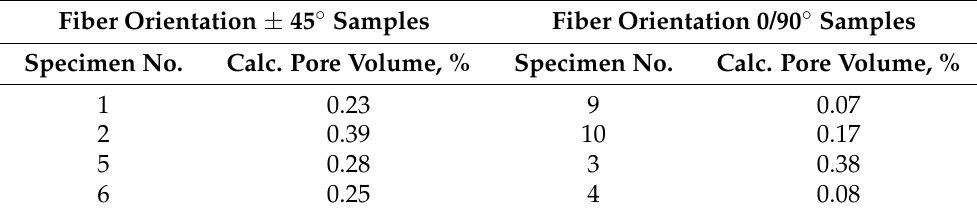
Table 2. Pore volume calculated from XCT data.